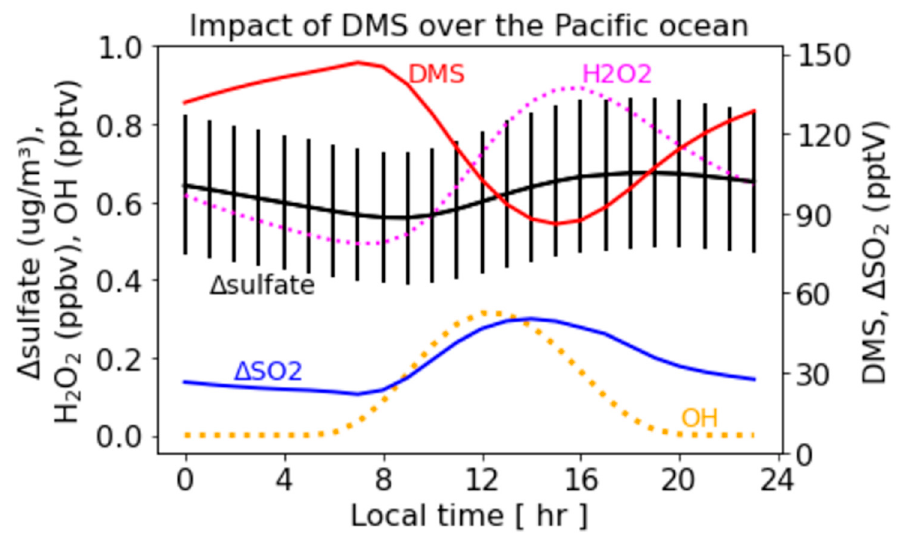
Figure 5. Diurnal variation in the impacts of DMS emissions on sulfate over the Pacific Ocean in July. All grid cells over the Pacific Ocean (including the Gulf of California) were used for the calculation. Solid vertical lines represent standard deviation of sulfate enhancement.